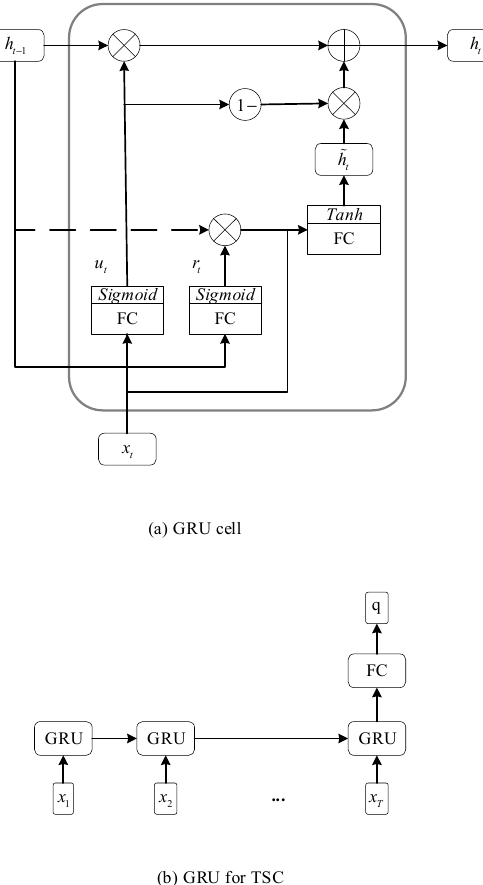
Figure 1. The schematic of the Gated Recurrent Unit (GRU) for time series classification (TSC).